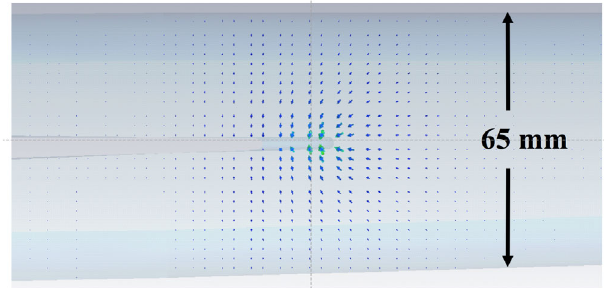
FIG. 13. Electric field line distribution for the trapped mode in model 3.